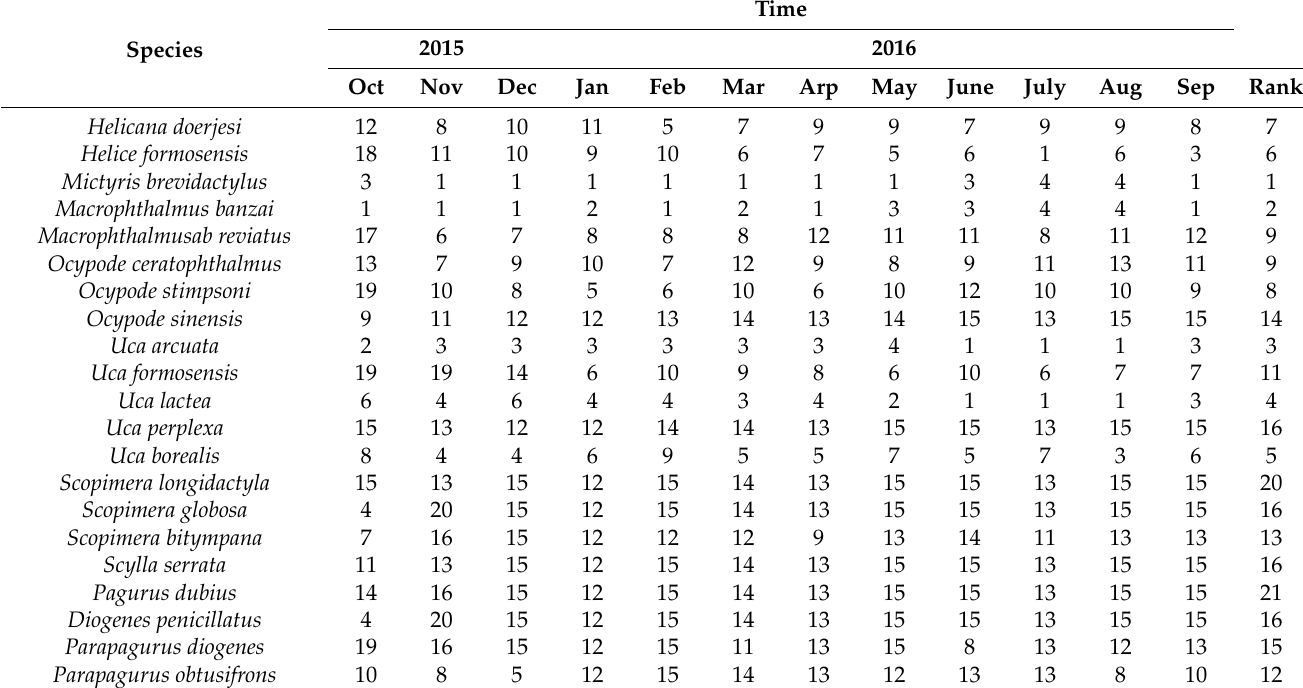
Table 2. The monthly rank of conditional co-occurrence probabilities of crab species in different